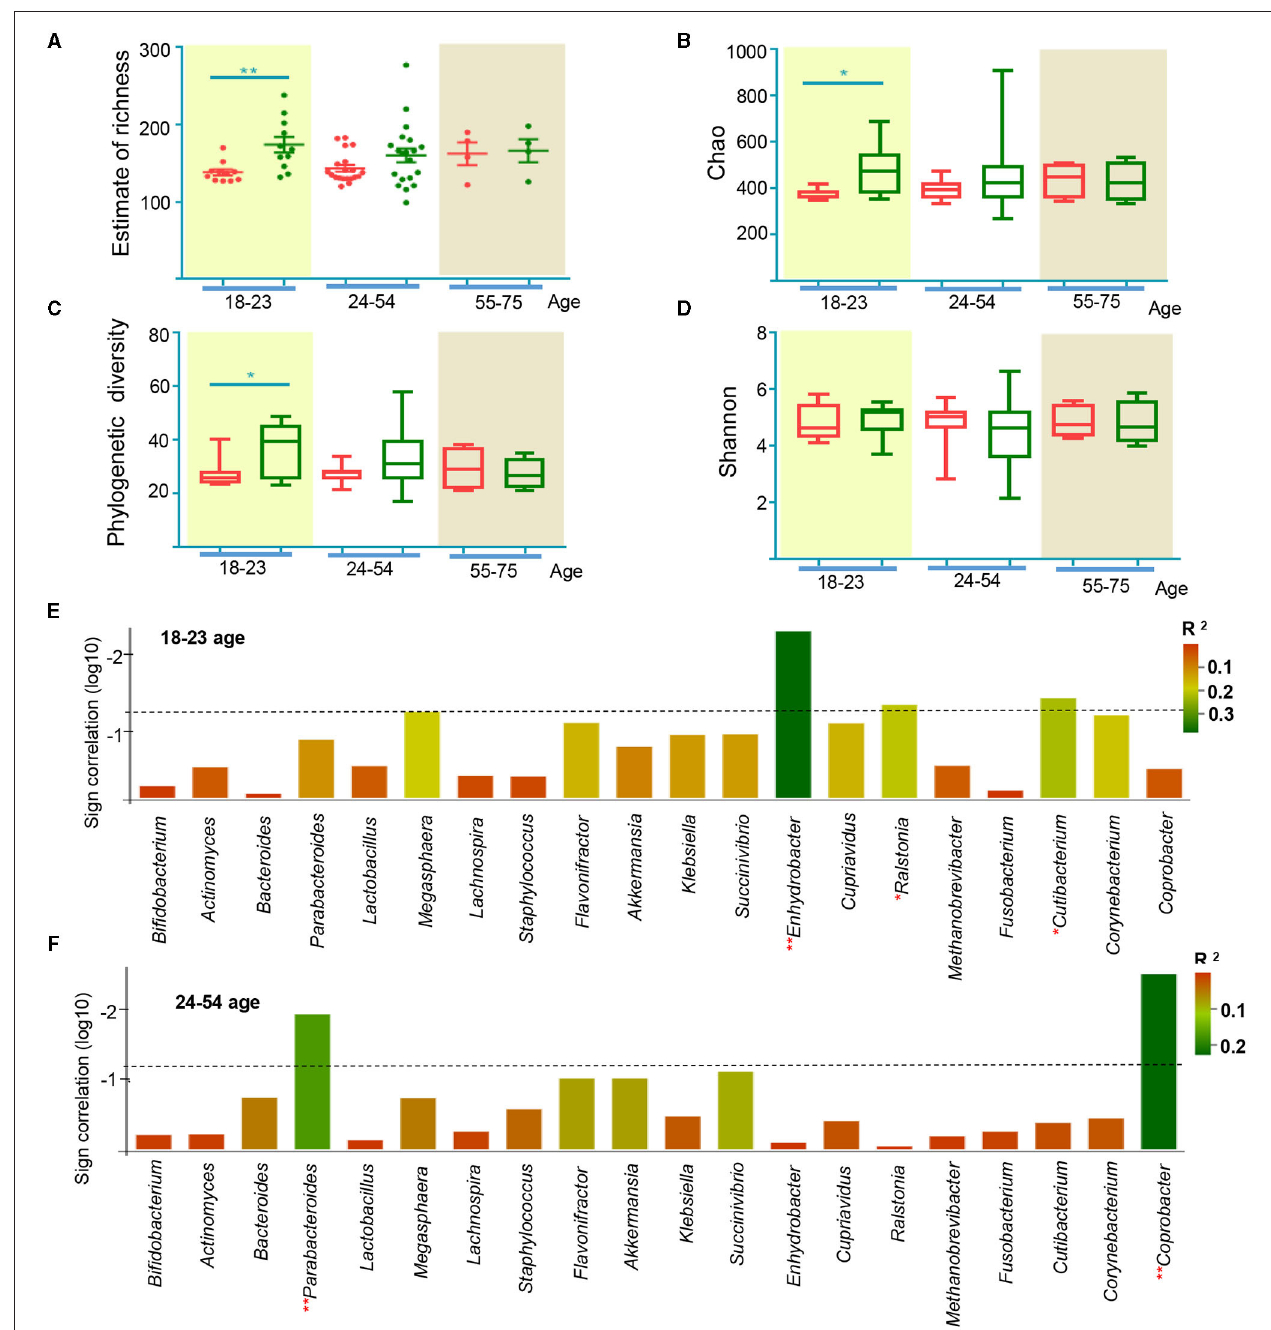
FIGURE 6 | Gut microbiome characteristics according to age from 18 to 23, 24 to 54, and 55 to 75. (A) The estimate of richness index analysis between age from 18 to 23, 24 to 54, and 55 to 75 at the level of and genus. * p < 0.05, ** p < 0.01, Mann Whitney test; alpha diversity indices of Chao index (B) , phylogenetic diversity index (C) , and Shannon index (D) according to age from 18 to 23, 24 to 54, and 55 to 75. * p < 0.05, ** p < 0.01, Wilcoxon rank-sum test; sign of the Spearman correlation between bacterial taxa and the average of SBMs according to age from 18 to 23 (E) , 24 to 54 (F) . Vertical axis represents the significance of Spearman correlation. The column surpasses the broken line means p < 0.05. Horizontal axis represents the taxa include discriminant genera by random forest analysis and the bacterial taxa generated by LEfSe. Colors represent the R 2 .